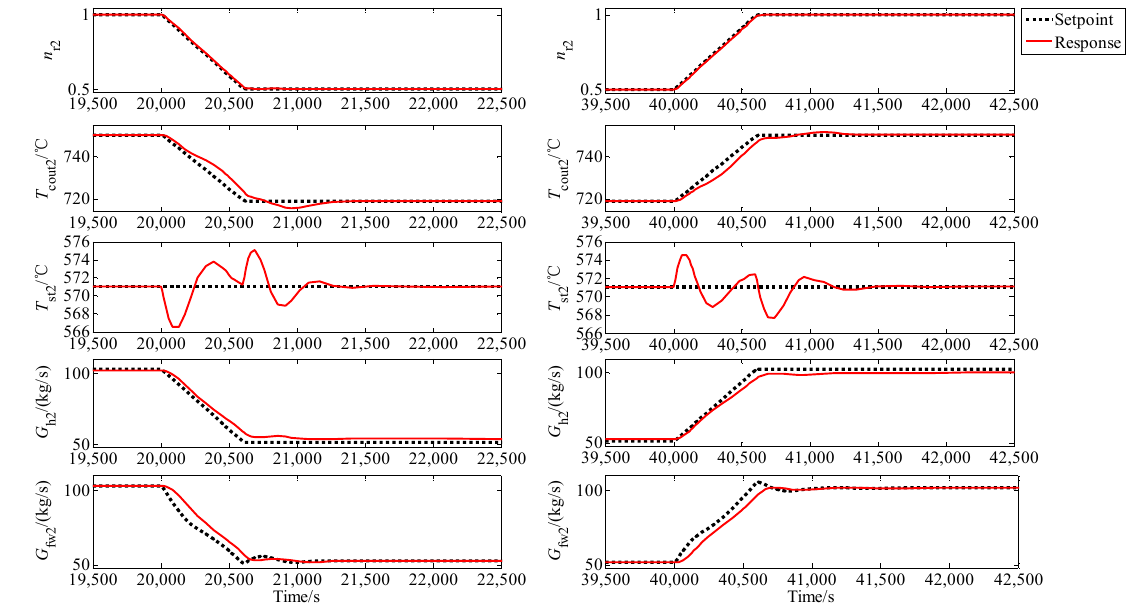
Figure 11. Responses of 2# MHTGR-based OTSSS, n r2 : normalized nuclear power, T cout2 : reactor outlet helium temperature, T st2 : live steam temperature, G h2 : primary helium flowrate, G fw2 : secondary feedwater flowrate. Energies 2017 , 10 , 1912